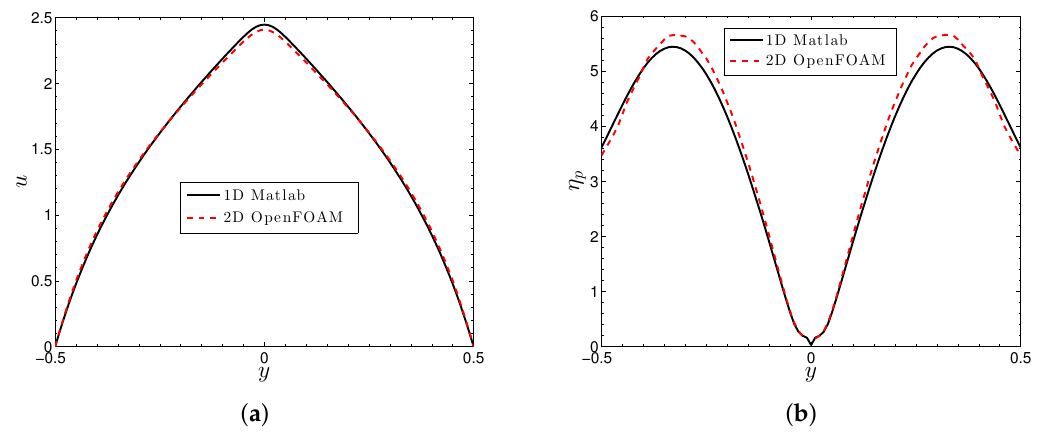
Figure 7. Plots of the ( a ) velocity and ( b ) particle viscosity across the gap from the 1D simulation versus the fully-developed 2D flow. The imposed pressure drop for the 1D simulation is P = 10 2 ; The inlet velocity for the 2D flow is U = 1.5133, which, over a unit gap width, is also the flow rate. Parameter values are: S = 10 − 1 , F = 10,